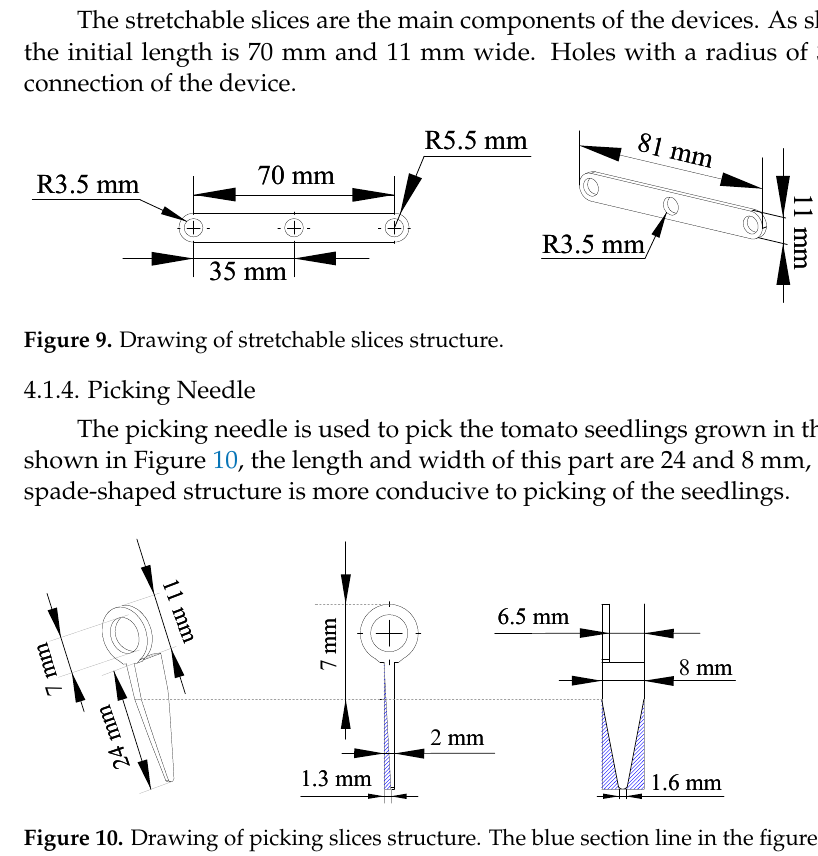
Figure 8. Drawing of pushing rod structure.